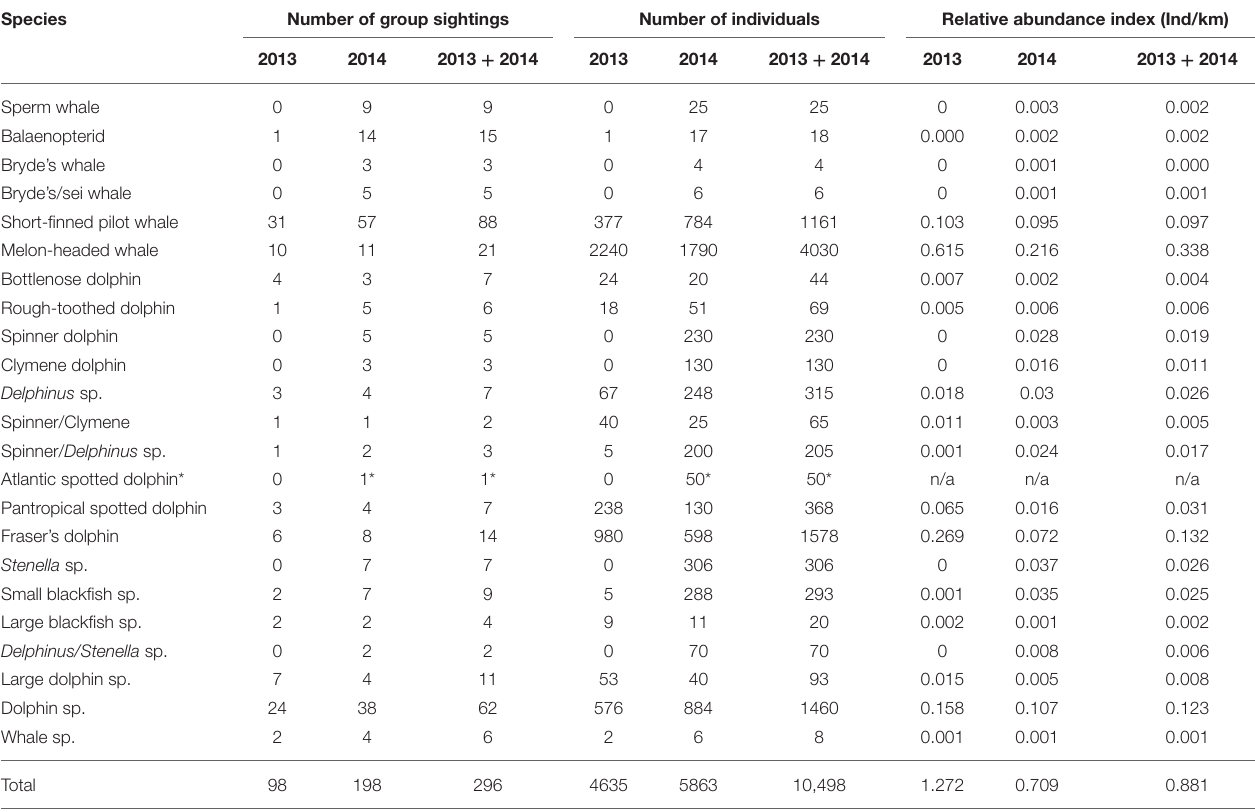
TABLE 1 | Summary of cetacean sightings, individuals (ind), and indices of abundance (the number of individuals per km effort) for the 2 survey years (3,644.9km effort in 2013 and 8,273.2km in 2014) and pooled (11,918.1km: 2013 + 2014).